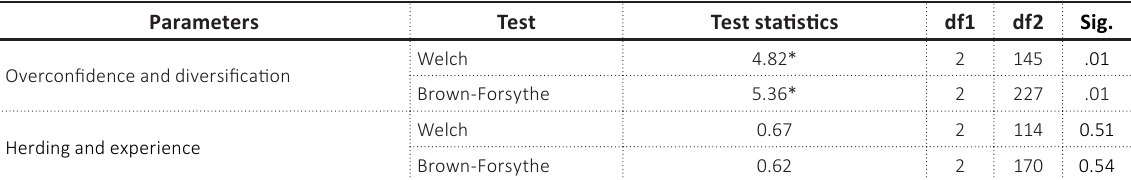
Note: * Significant at the 5 percent level.